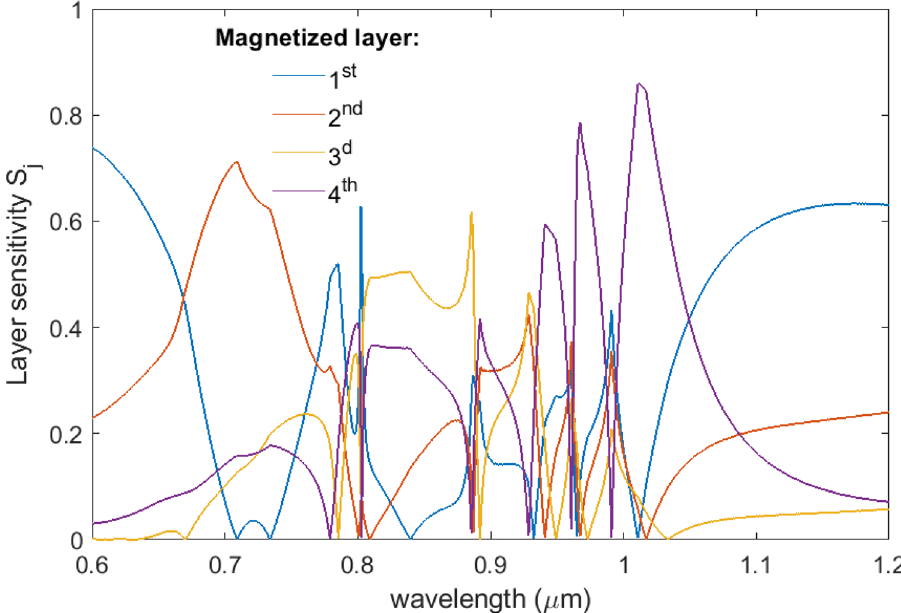
Figure 5. A layer sensitivity of the observed total Faraday rotation to the magnetization of a certain GdFeCo layer of the chirped MPC.